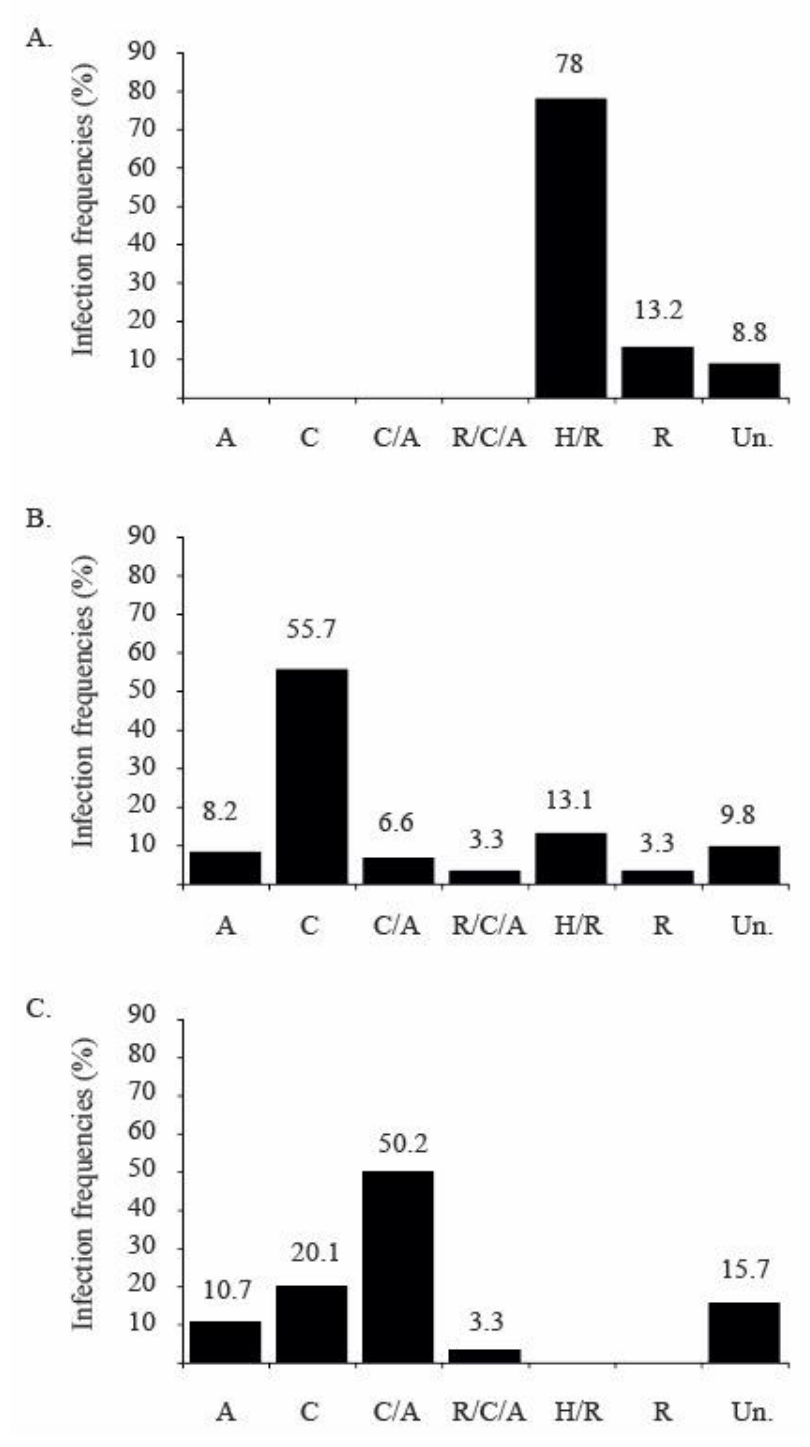
Figure 3 . Infection frequencies of the different endosymbiont combinations observed in individuals of MEAM1 ( A ), Hybrids ( B ) and Indian Ocean ( C ) populations of Bemisia tabaci collected in the field in Reunion Island. A: Arsenophonus , C: Cardinium , H: Hamiltonella , R: Rickettsia , and Un.: Undetected.